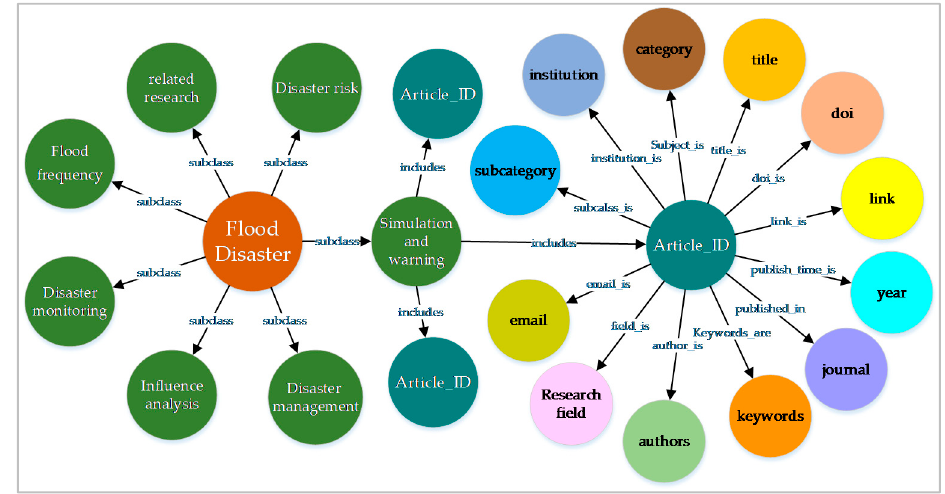
Figure 6. Organization model of flood disaster literature data.